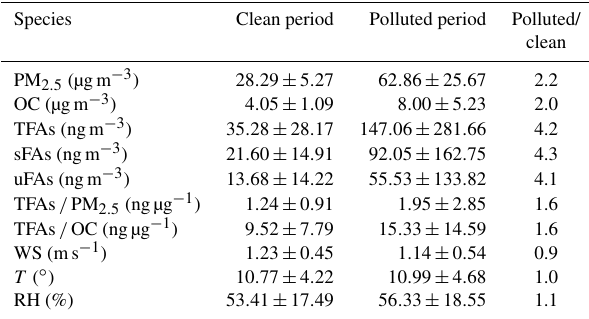
Table 2. PM 2 . 5 concentration, organic carbon fraction, fatty acid concentration and meteorological conditions during the clean and polluted